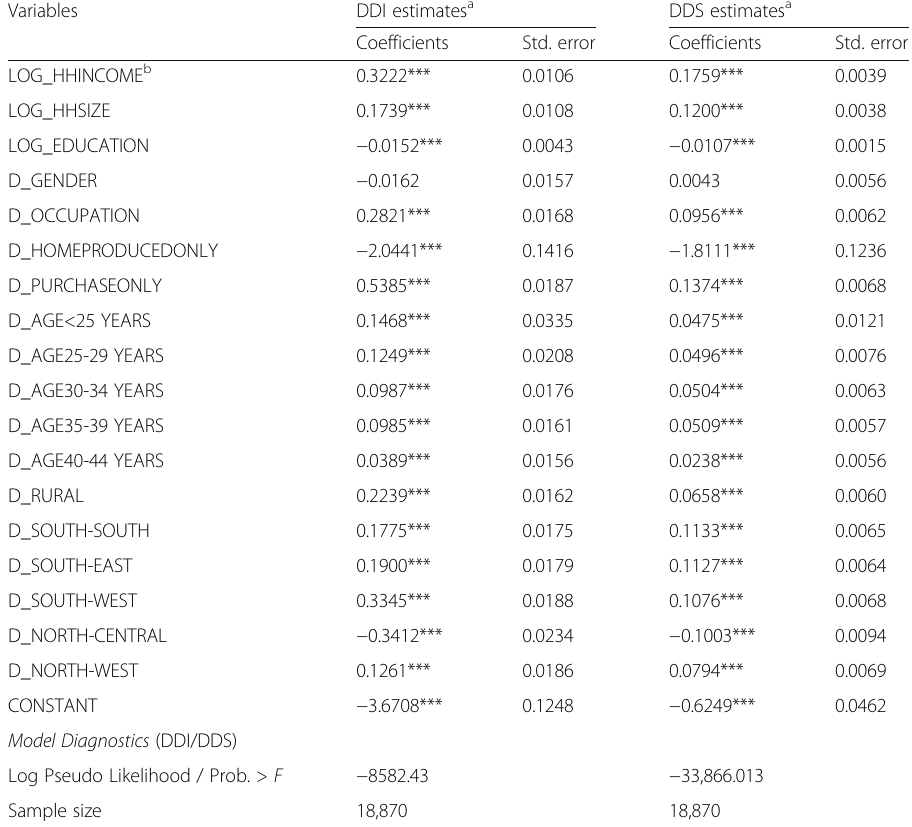
Table 4 Determinants of household demand for dietary diversity